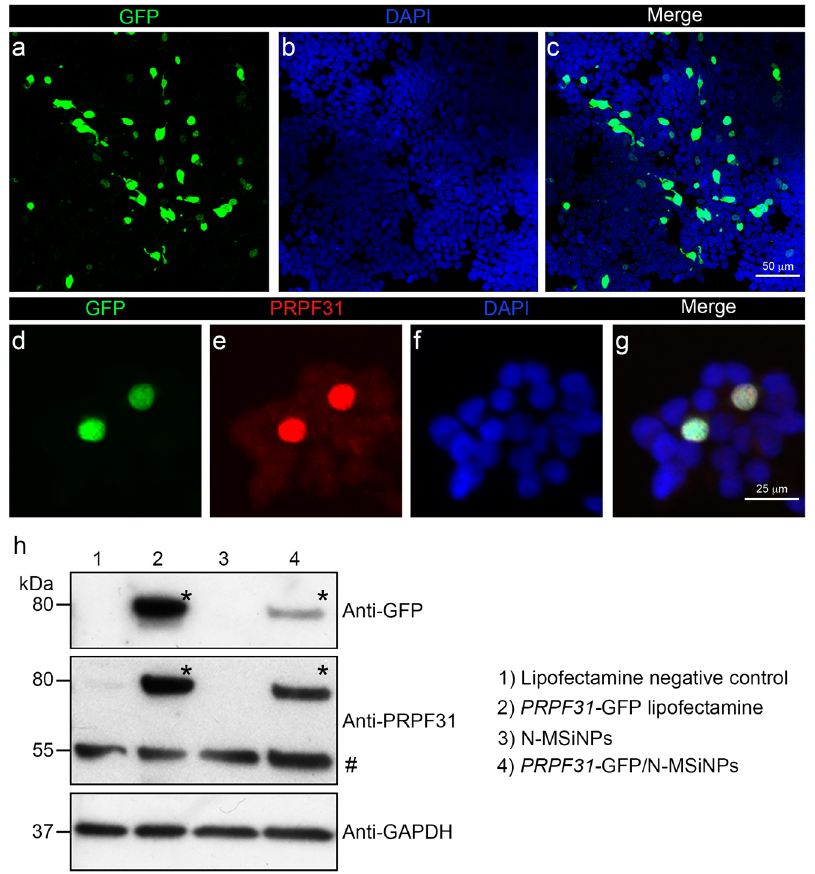
Figure 5. Transfection efficacy of PRPF31 gene using the nanoparticle delivery system PRPF31 -GFP/N-MSiNPs in a human cell line. Panels ( a – g ), immunofluorescence images of HEK-293 cells transfected with N-MSiNPs loaded with the PRPF31 -GFP plasmid. GFP fluorescent signal ( a , d ), in green; anti-PRPF31 fluorescent signal ( e ), in red. Cell nuclei were stained with DAPI ( b , f ), in blue. Merged images of the different channels are shown in ( c , g ). ( h ) WB of HEK-293 transfected cells showing the expression levels of the PRPF31 transgene fused to GFP. Protein extracts of HEK-293 treated with only Lipofectamine (negative control), in lane 1; from cells transfected with PRPF31 -GFP using Lipofectamine, in lane 2; from cells incubated with empty N-MSiNPs, in lane 3; and from cells transfected with N-MSiNPs loaded with PRPF31 -GFP, in lane 4. WBs were performed with anti-GFP (upper panel) and anti-PRPF31 (central panel) antibodies. GAPDH was used as a loading control (bottom panel). The (*) in the upper and central panels marks the expected molecular weight (80 kDa) of the PRPF31-GFP fused protein visualized by anti-GFP and ant-PRPF31 antibodies. The (#) in the central panel marks the expected molecular weight (55 kDa) of the endogenous PRPF31 protein. Scale bars represent 25 and 50 µm.